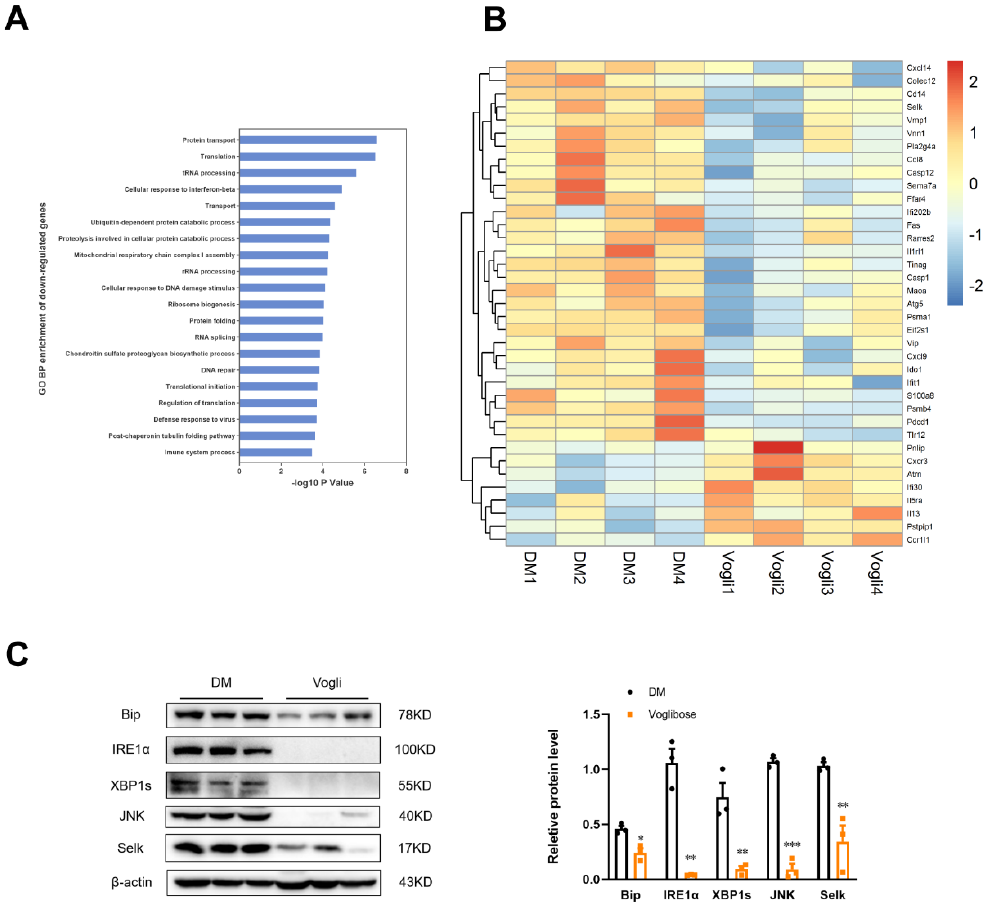
Figure 5. Voglibose decreases protein and gene expression of ERS-related factors. ( A ) Histogram of the enrichment of differential genes in GO biological processes. The results of the first 20 terms with the most significant enrichment are shown in the histogram ( p < 0.05). ( B ) The heatmap for differentially expressed genes in the GeneChip microarray analysis. ( C ) Protein abundance of Bip, IRE1 α , XBP1s, JNK and Selk. n = 3. Data are expressed as the mean ± SEM and individual data